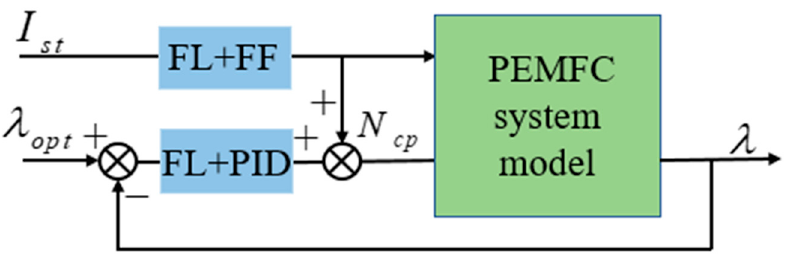
Figure 11. Structure of fuzzy feedforward plus fuzzy PID controller.